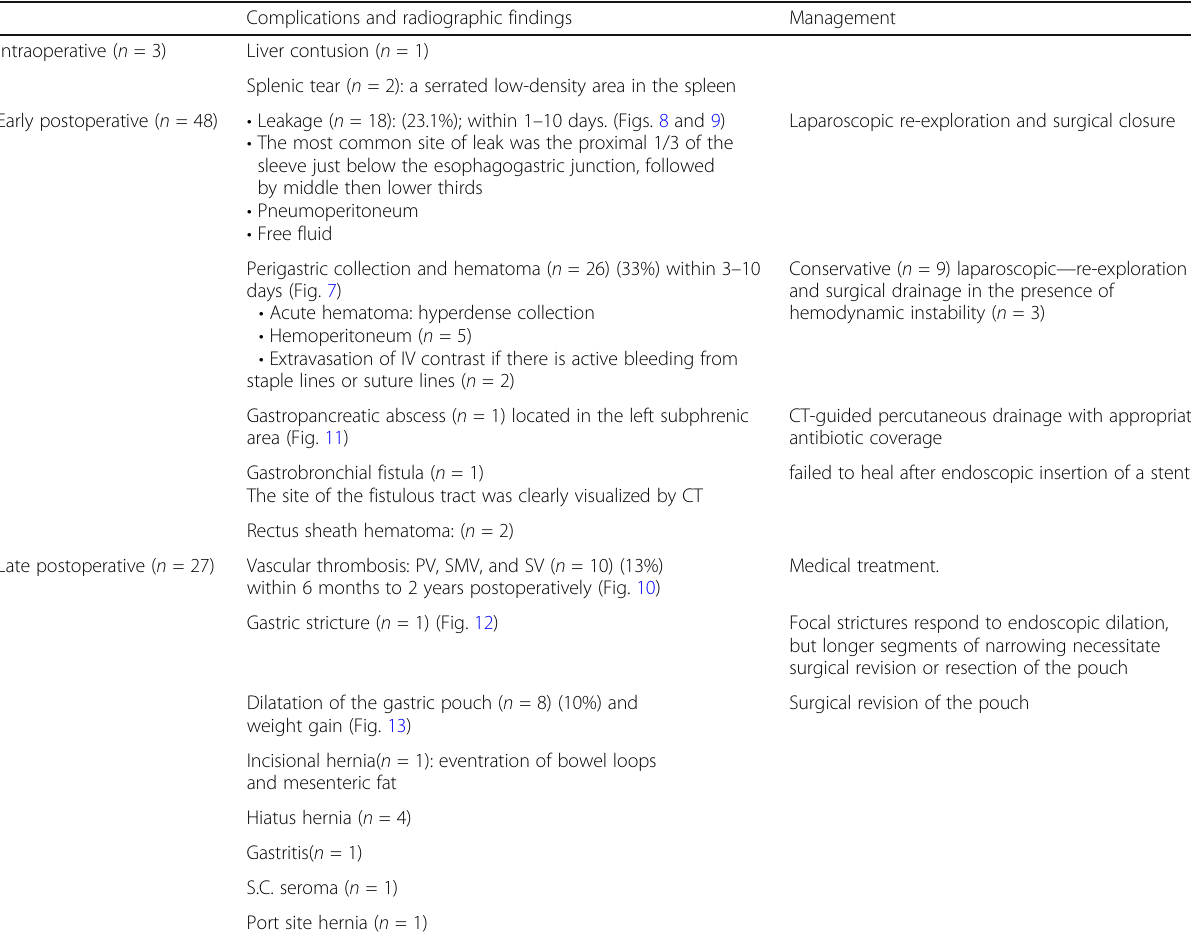
Table 3 Complications of laparoscopic sleeve gastrectomy